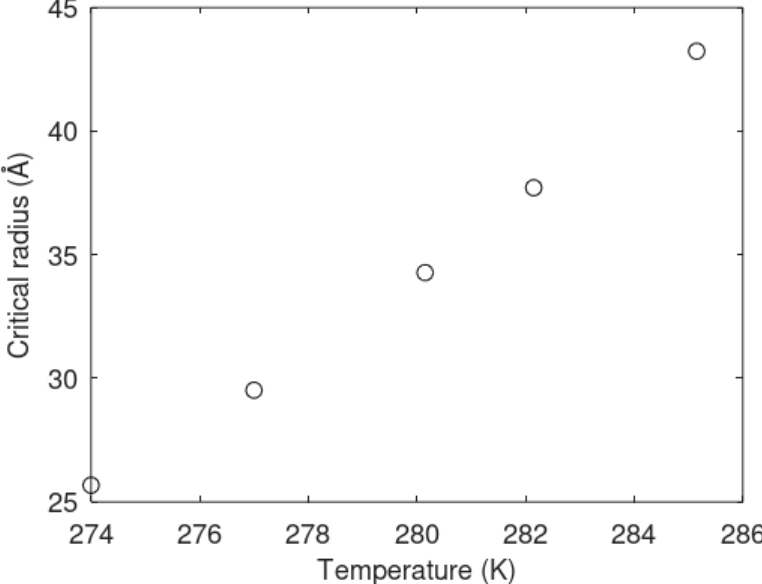
Figure 17. Critical radius for CH 4 hydrate core formed heterogeneously on CH 4 /liquid water interface as function of temperature.